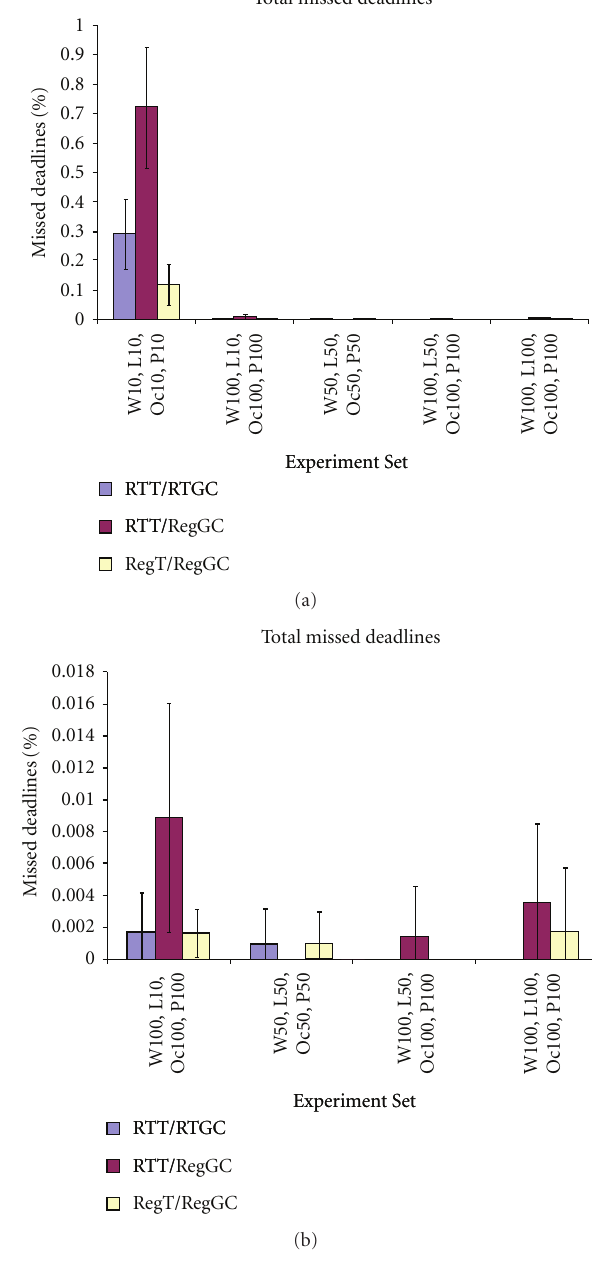
Figure 11: Percentage of missed deadlines (a) for all five experiment sets and (b) for the four experiment sets with a lower missed deadline percentage (rescaled to show more